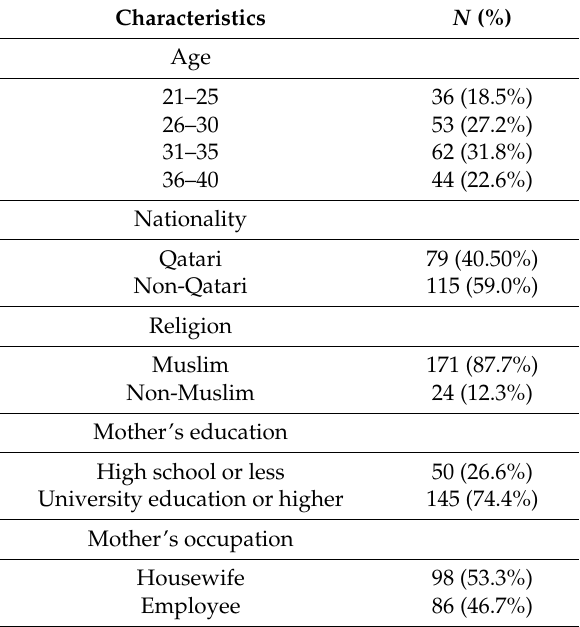
Table 1. Socio-demographic characteristics of